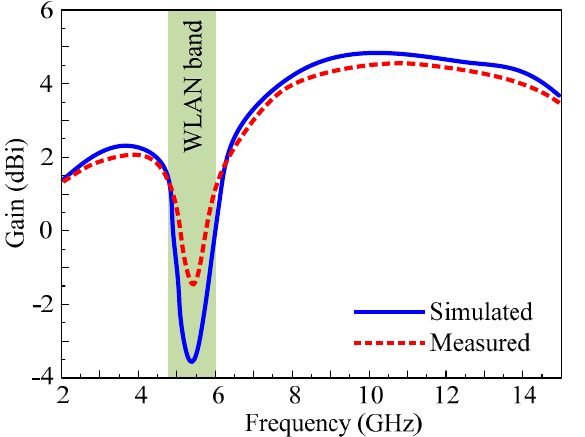
Figure 6. Simulated and measured gain of the proposed notch band extended UWB antenna.